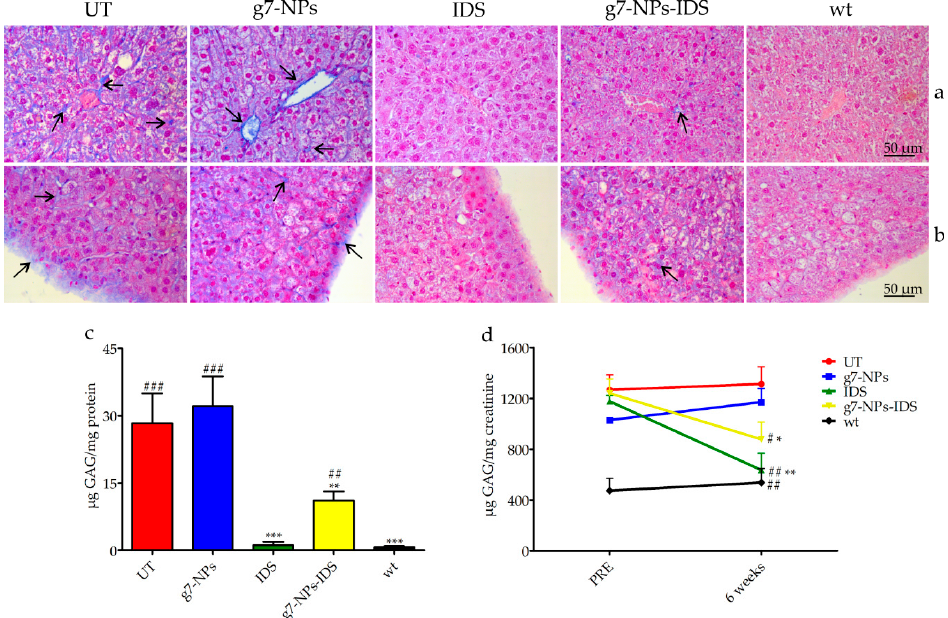
Figure 3. Analysis of GAG in the liver and urine of treated Ids-ko mice. Histochemical and biochemical analysis of GAG in liver and urine of Ids-ko mice treated with 0.9% NaCl (untreated, UT), g7-NPs, free IDS, g7-NPs-IDS, and in wt mice, after 6 weeks of treatment. Representative sections of ( a ) hepatic vessels and ( b ) Glisson’s capsule. Arrows indicate GAG deposits. Sections (7 µ m) were stained with 1% Alcian Blue pH 2.5, counterstained with 0.1% Nuclear Fast Red. ( c ) GAG content ( µ g GAG / mg